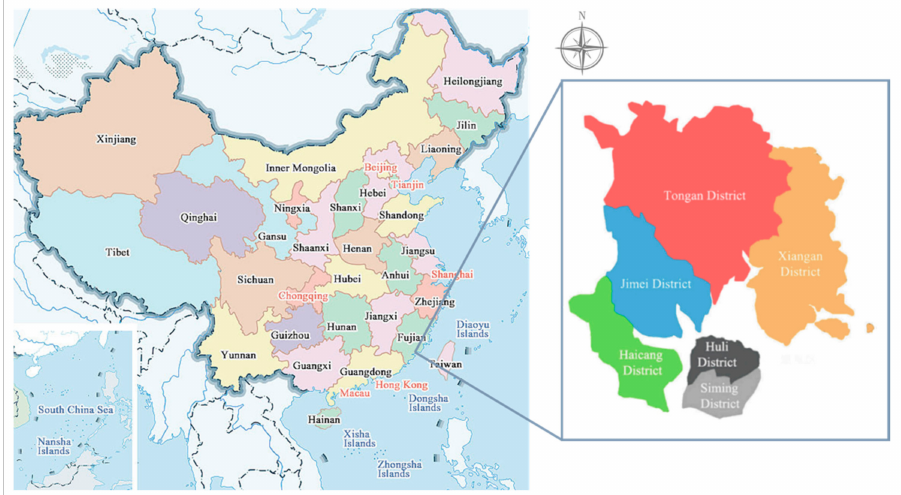
Figure 1. The location of Xiamen in China and the administrative divisions of the